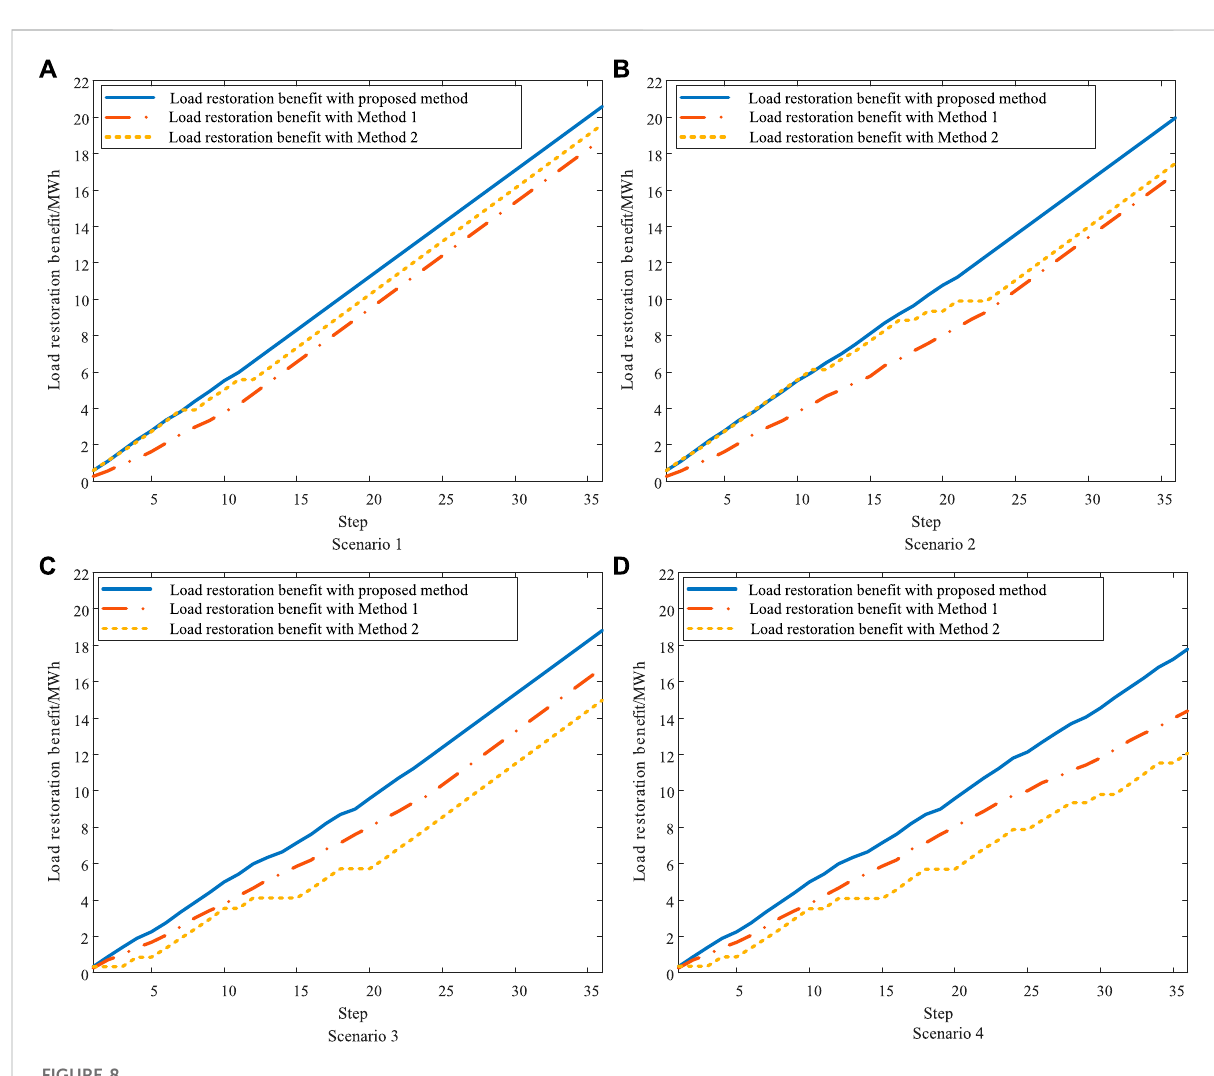
FIGURE 8 Load restoration results in different scenarios. (A) Load restoration bene fi t with three methods in scenario 1. (B) Load restoration bene fi t with three methods in scenario 2. (C) Load restoration bene fi t with three methods in scenario 3. (D) Load restoration bene fi t with three methods in scenario